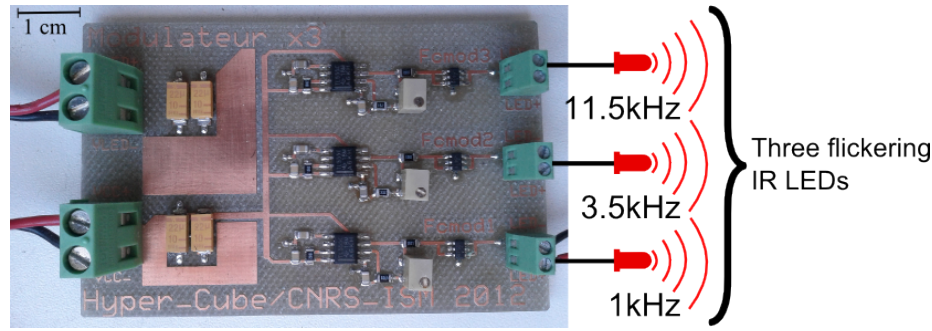
Figure 4. Custom-made electronic board for the frequency modulation of the IR LEDs. It produces three separate signals that flicker at 1 kHz, 3.5 kHz and 11.5 kHz, sent to the three IR LEDs of the object to be